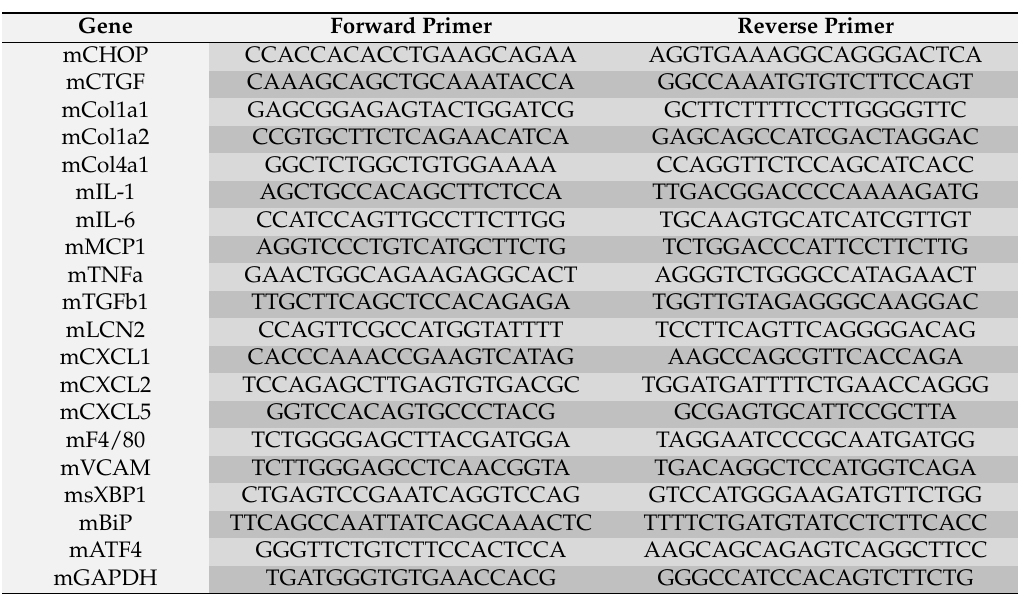
Table 1. The list of primer